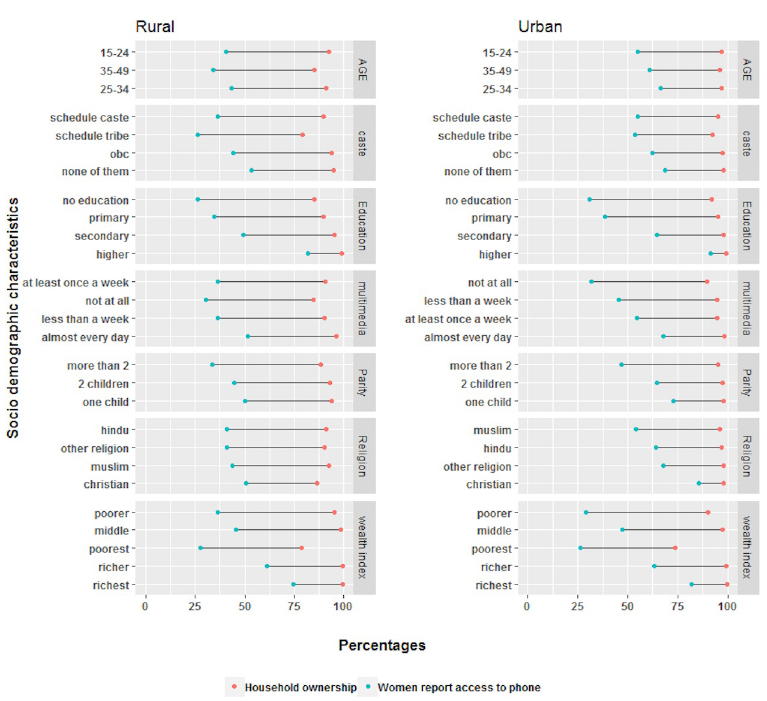
Fig 4. Differentials in rural and urban household ownership of mobile phones and women’s reported access by socio-demographic characteristics. Categories are listed by the descending order of the gap between household ownership and women’s